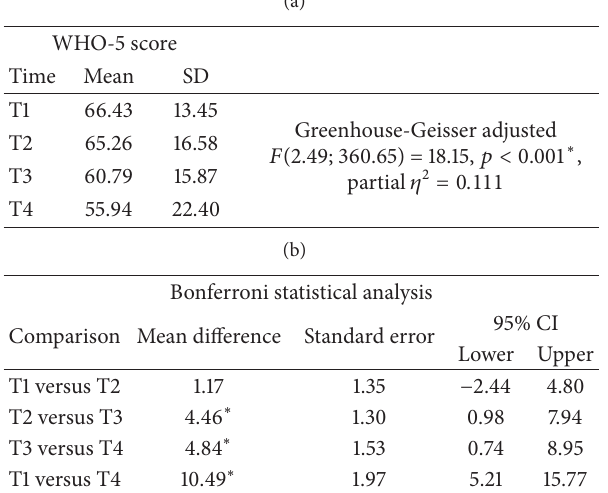
Table 1: Effect of time on students’ positive psychological well- being, across the second academic